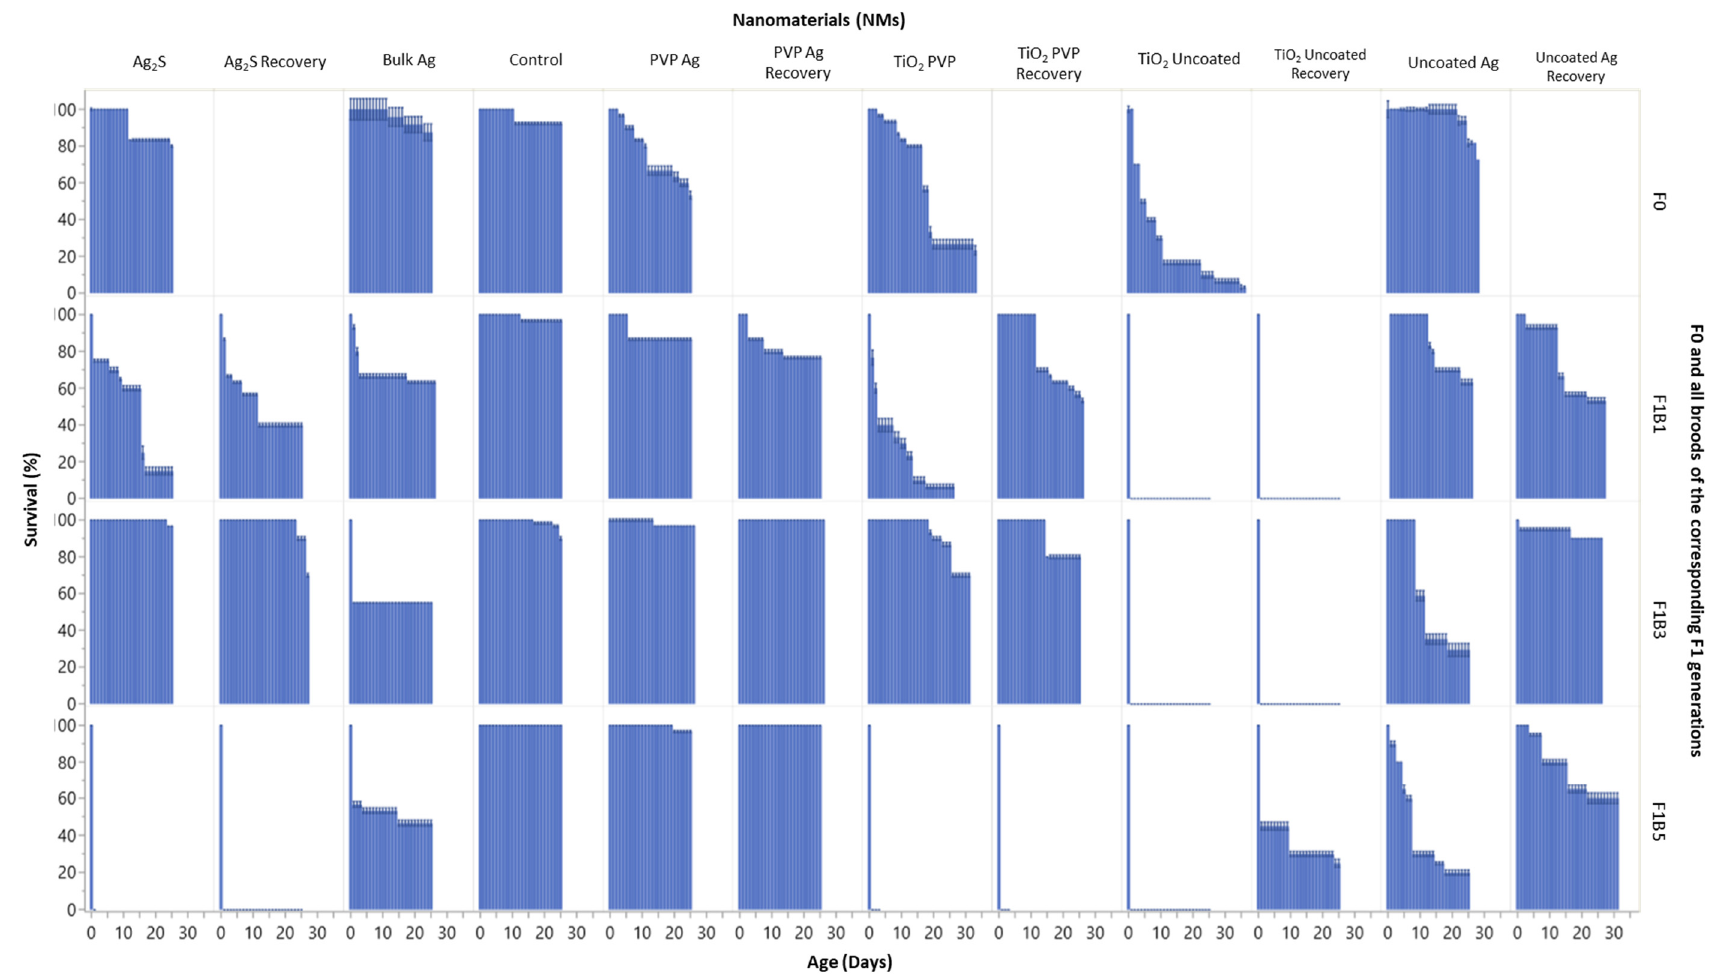
Figure 1. Survival (%) versus age (days) for all F0 generations and broods F1B1, F1B3 and F1B5 of the subsequent F1 generations. Data are presented for daphnids continuously exposed to each of the Ag and TiO 2 NMs, and those in the recovery sets after removal from exposure ( n = 5). The Y -axis indicates the average daphnid survival (%) as a function of daphnid age (days) on the X -axis. F0 = Parent exposure to the particular NM are noted at the top of the plots.